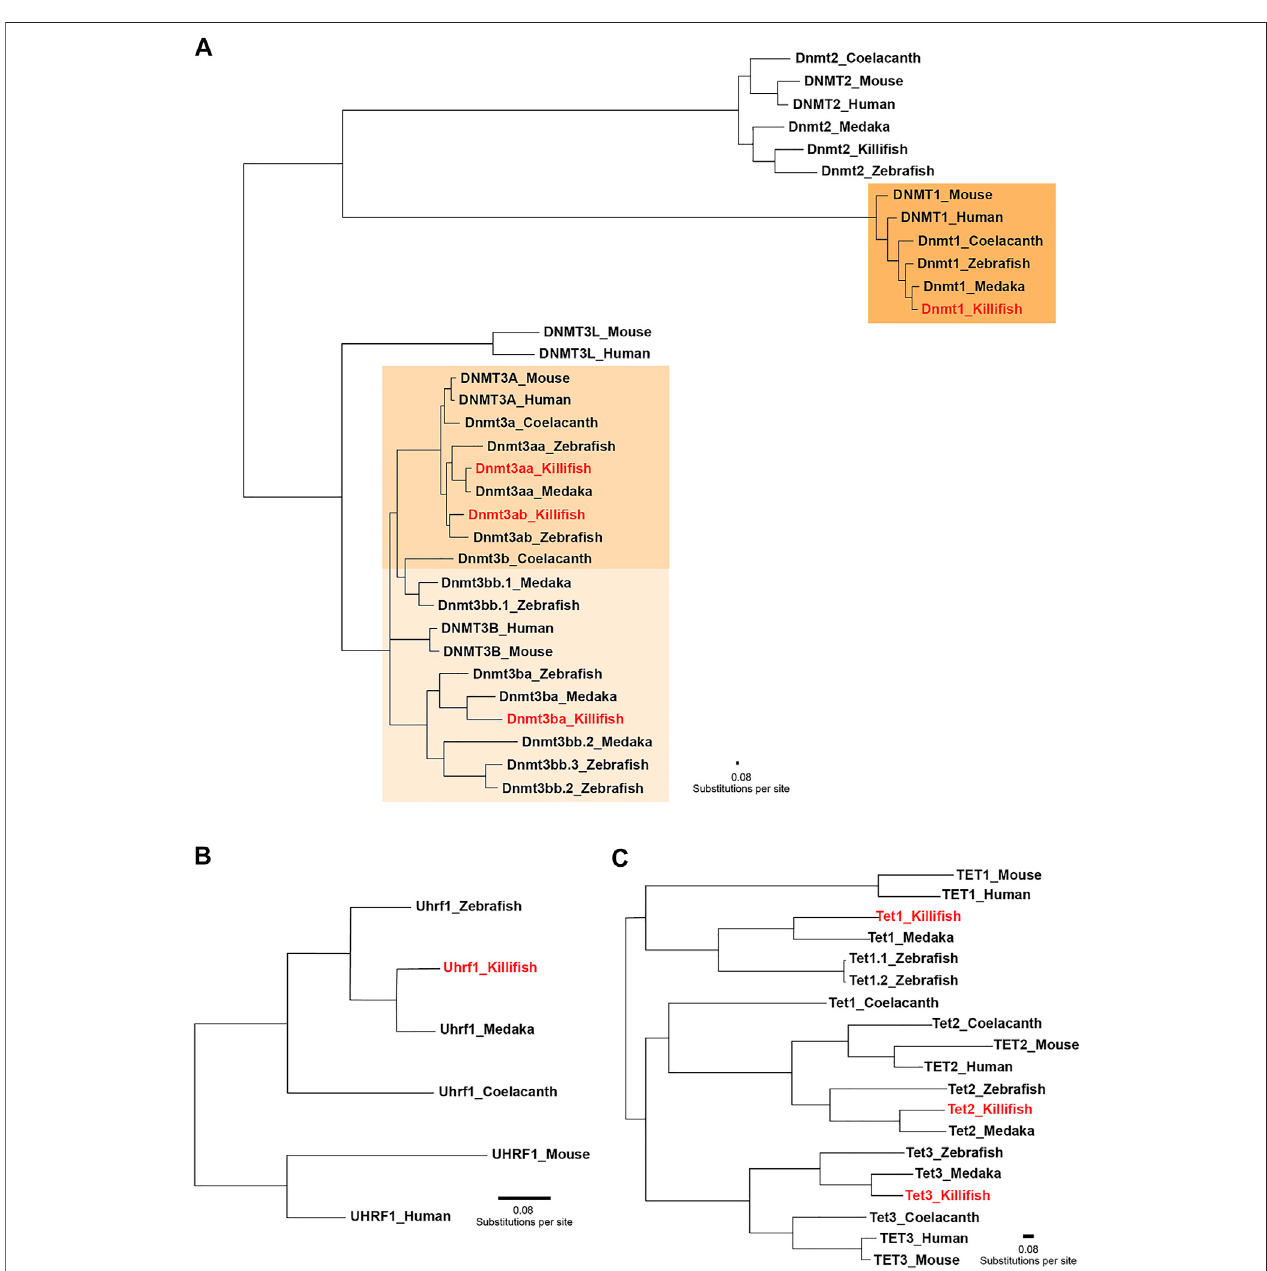
FIGURE1| PhylogeneticrelationshipsbetweenkeyenzymesconstitutingtheDNAmethylationmachinery.PhylogenetictreeofvertebrateDNAmethyltransferases (DNMTs) (A) DNMT1 recruitment factor UHRF1 (B) and ten-eleven translocation methylcytosine dioxygenases (TETs) (C) computed by the Maximum-Likelihood algorithm. Full protein sequences obtained from the following species were used: human ( Homo sapiens ), mouse ( Mus musculus ), zebra fi sh ( Danio rerio ) , medaka ( Oryzias latipes ) , killi fi sh ( Nothobranchius furzeri ), and coelacanth ( Latimeria chalumnae ) . Coelacanth represents a sarcopterygian fi sh illustrating the transition to a terrestrial life, creating modern tetrapods. The scale bar represents number of substitutions per site.